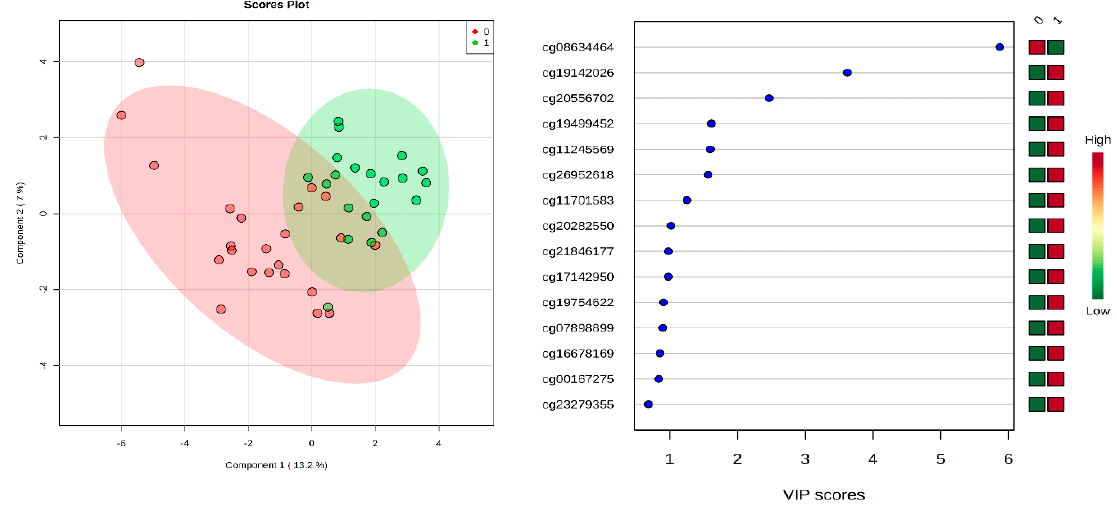
Figure 2. Two-dimensional partial least squares discriminant analysis (PLSDA-2D) of CP cases and control subjects. The red nodes (0) depict cases while the green nodes (1) represent controls.